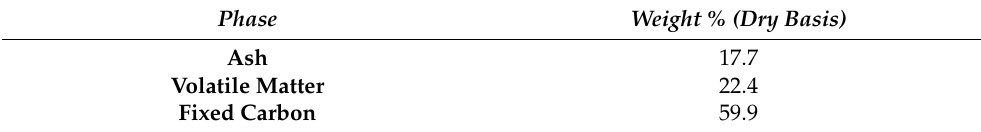
Table A1. Results of the proximate